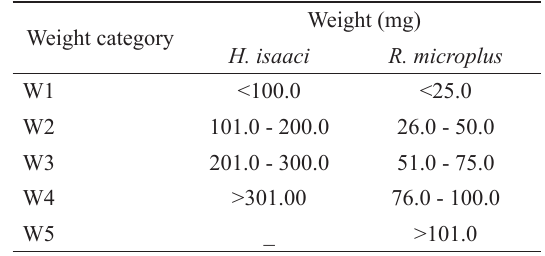
Table 1: Weight categories of Hyalomma isaaci and Rhipicephalus microplus gravid females collected from the